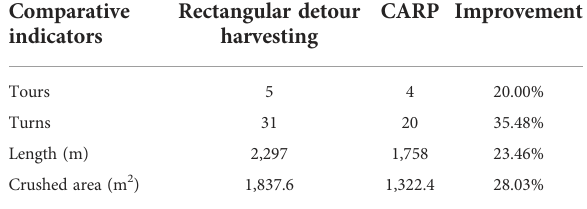
TABLE 5 Comparison of differentharvesting methods for regular fi